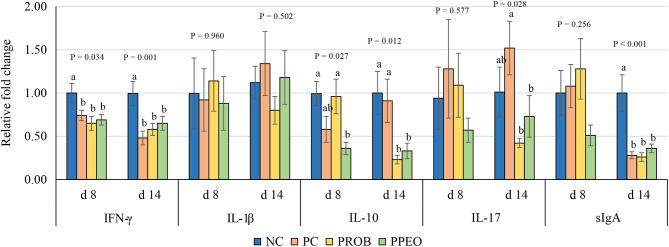
Relative mRNA abundance of interferon (IFN)-ɤ, interleukin (IL)-1β, IL-10, IL-17 and secretory immunoglobulin (sIg)A in the jejunum of broiler chickens on day (d) 8 and 14. Birds reared under a naturally occurring necrotic enteritis challenge model. Treatments include: NC (negative control): corn-soybean meal basal diet; PC (positive control): NC + 20 g virginiamycin (453 g Stafac®20)/ton diet; PROB (Probiotic): NC + B. licheniformis spores at the level of 227 g/ton diet; PPEO (probiotic/prebiotic/essential oil supplement): NC + 453 g/ton of a supplement containing B. licheniformis spores, mannan-oligosaccharides, β-glucans (1,3 and 1,6), capsaicin, and curcuma. Values are represented as a n-fold difference relative to the calibrator (NC). Results are given as means (n = 8) for each treatment. Error bars indicate standard errors. For each gene and sampling day, columns with different letters are significantly different (P < 0.05).